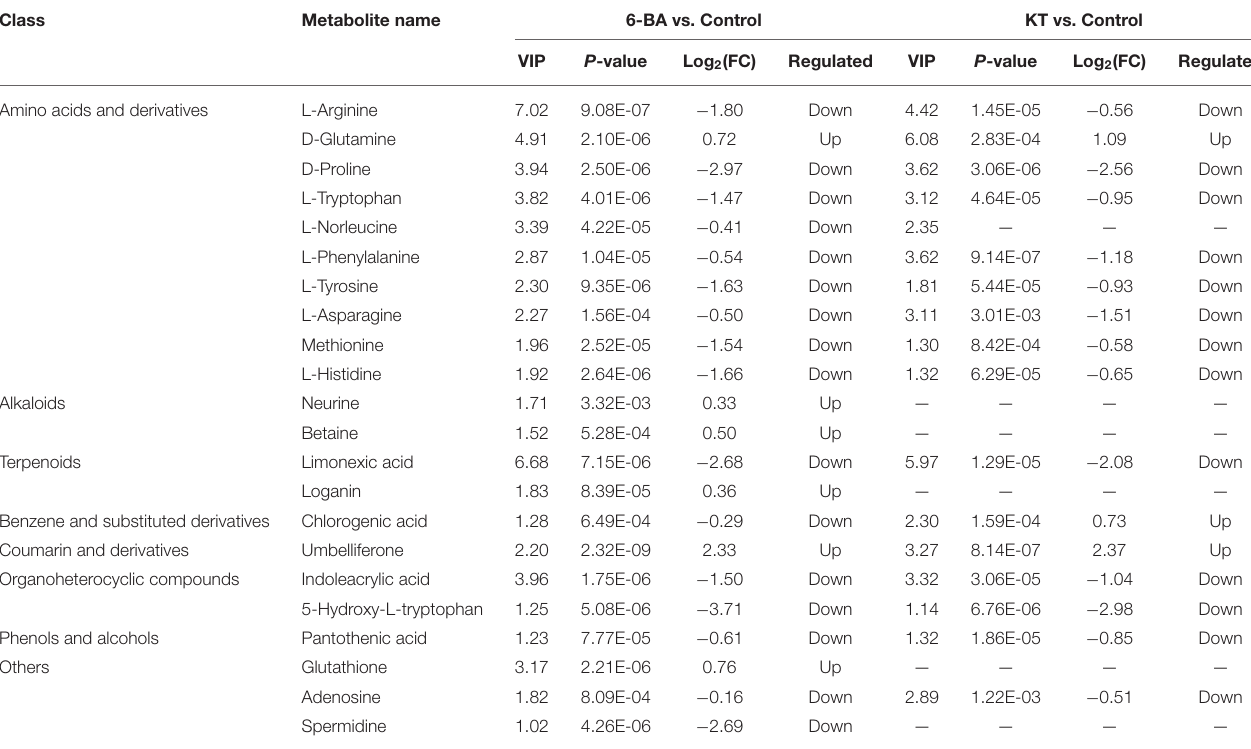
TABLE 1 | Regulation of different PGRs on differential metabolites.